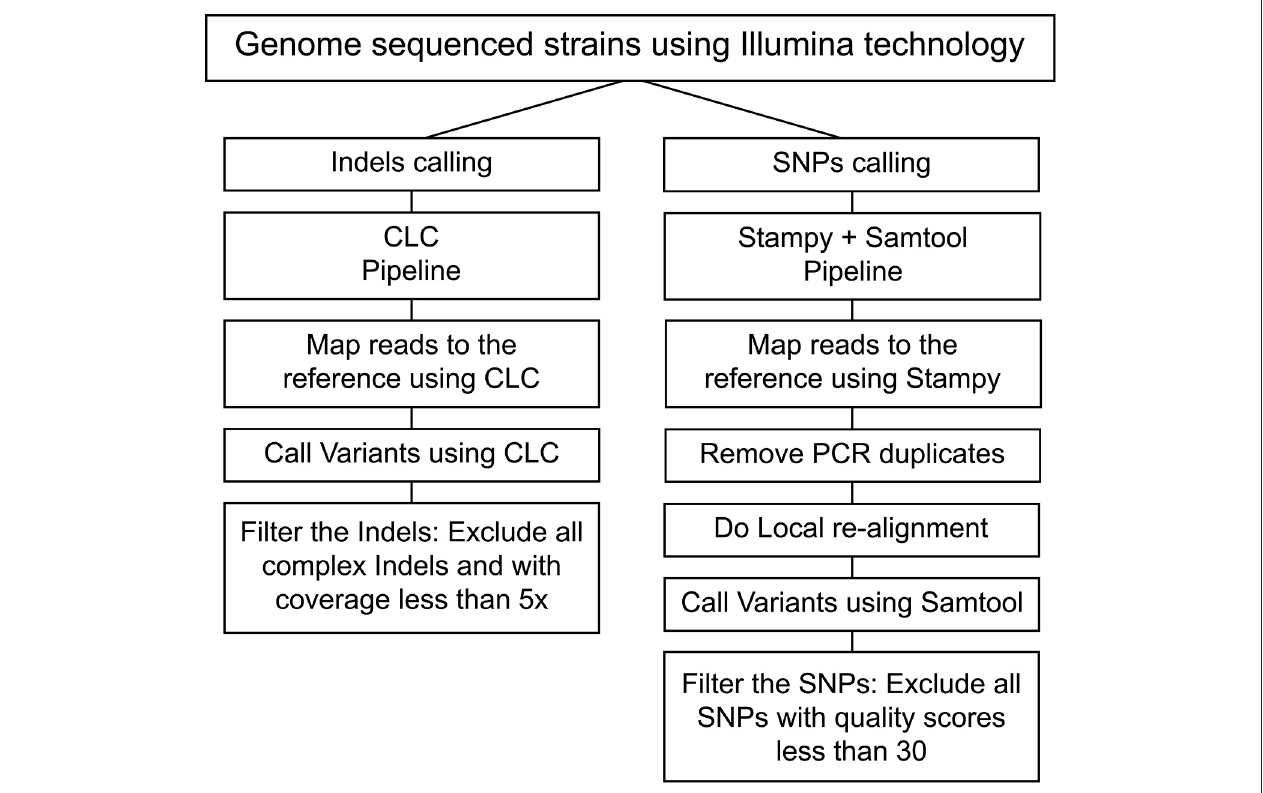
FIGURE 1 | Pipeline process to identify SNPs and Indels. The flowchart represents the pipelines employed for calling SNPs (Stampy and Samtools) and Indels (CLC).